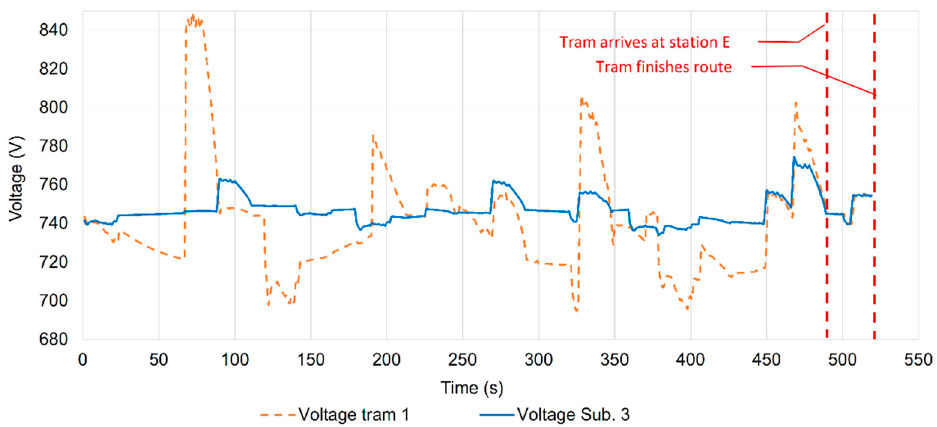
Figure 6. Simulation results (voltage tram 1 and voltage substation 3).